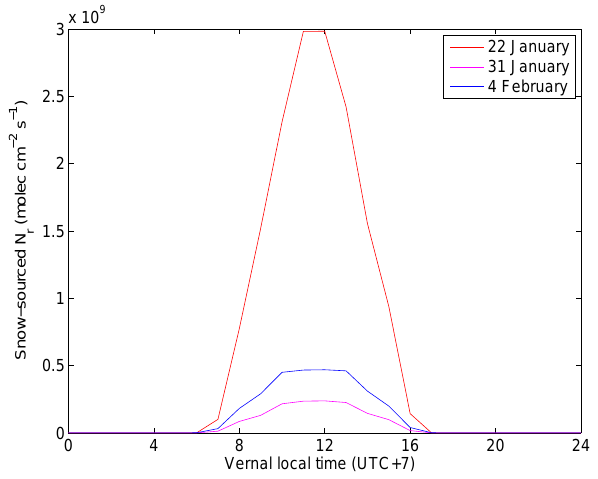
Figure 5. Modeled diurnal profiles of snow-sourced N r fluxes ( F N moleccm − 2 s − 1 ) calculated using TRANSITS on 22 January (red), 31 January (magenta), and 4 February (blue).